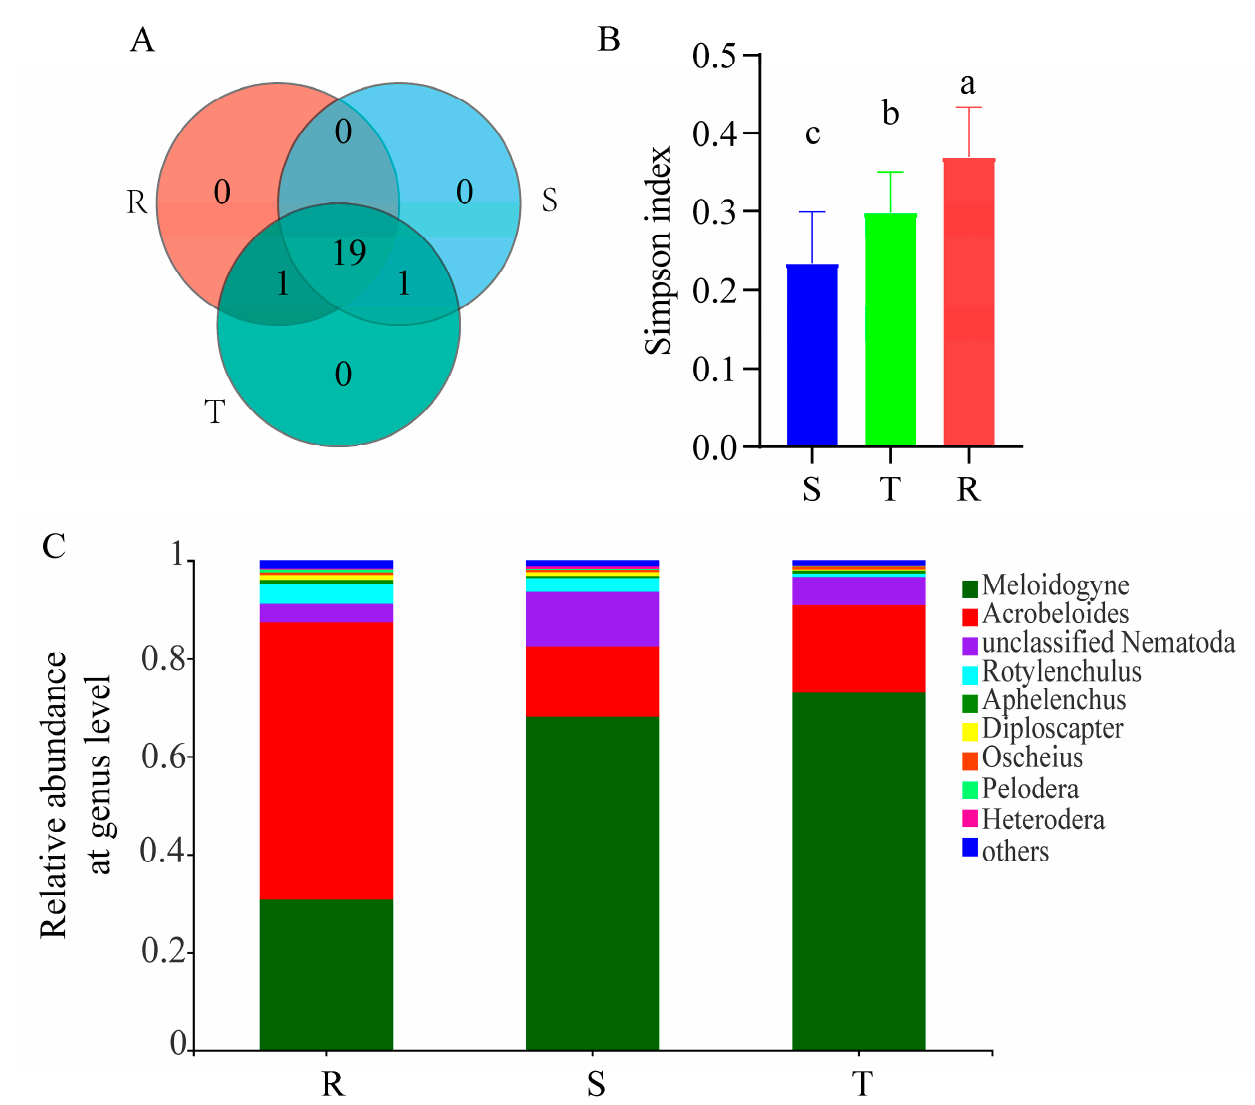
Figure 1. Alpha diversity of soil nematode community. ( A ), Number of species. ( B ), Simpson index. ( C ), Composition of soil nematode community at genus level. Different letters between the columns show the significant difference between the three tomato cultivars. S: susceptible cultivar. T: tolerant cultivar. R: resistant cultivar.